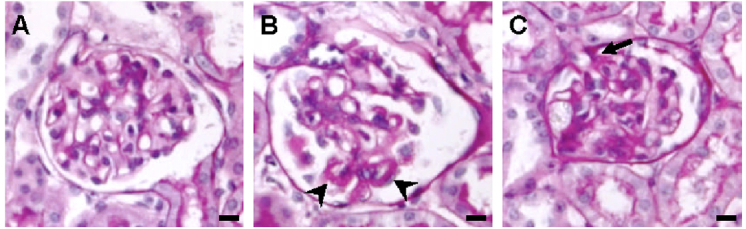
Representative images of the histology observed 7 days after NTS administration showing a normal glomerulus (A), a glomerulus with hyaline deposits indicated by arrowheads (B), and a glomerulus with a bridge formed between the glomerular tuft and the Bowman capsule indicated by an arrow (C). Bar = 20 μm.